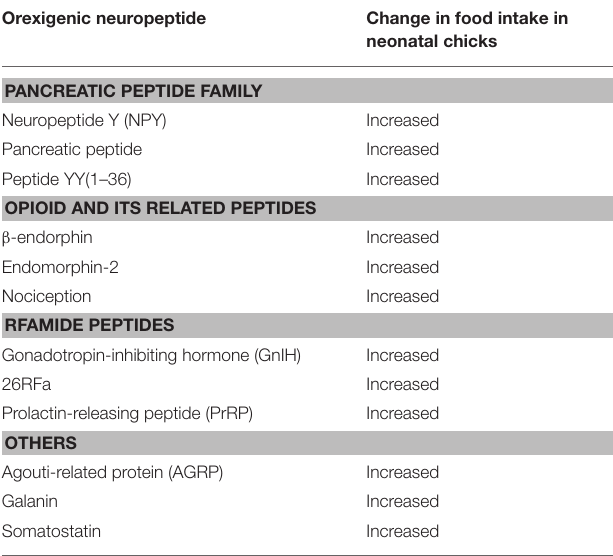
TABLE 2 | Neuropeptides showing orexigenic effects on feeding behavior in